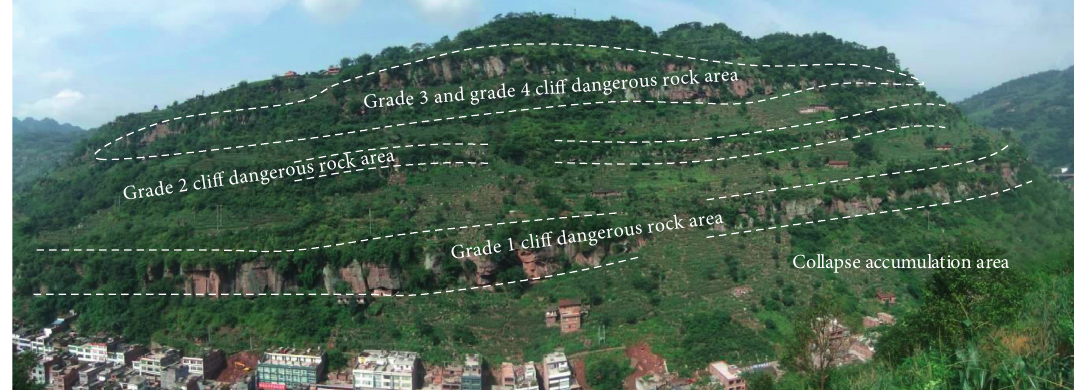
Figure 3: Geomorphologic map of the collapse and accumulation area and cliff dangerous rock